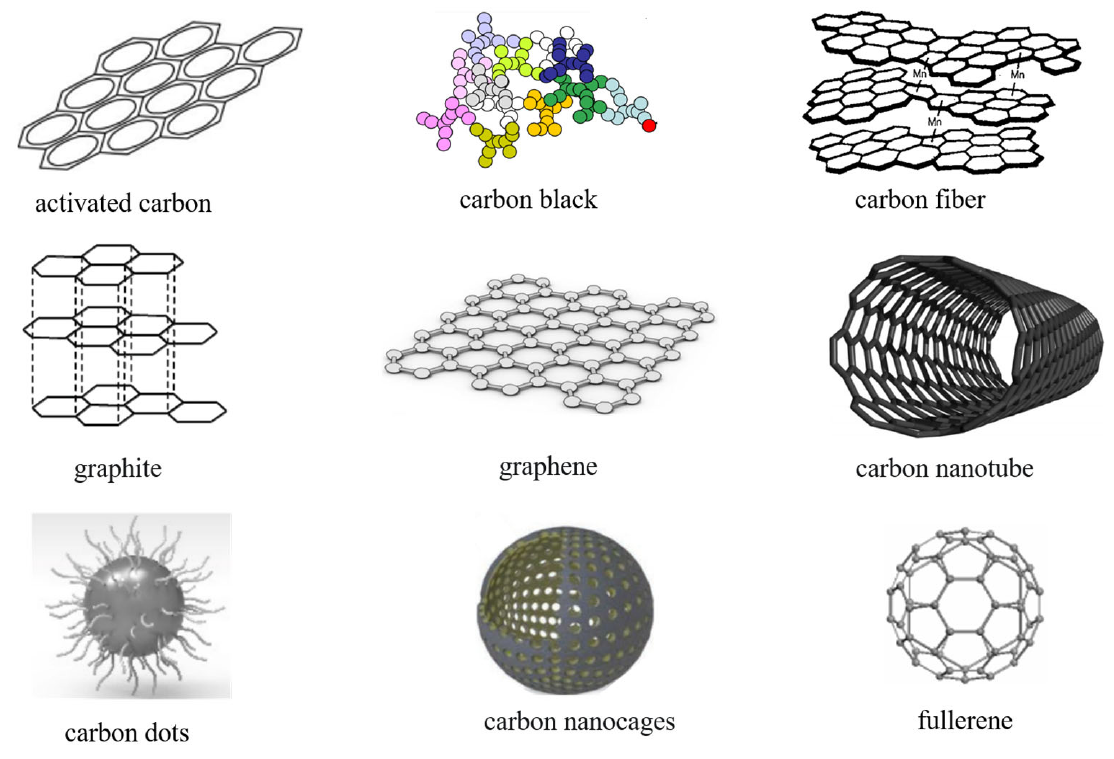
Figure 3. Structures of various carbon ‐ based materials. Reproduced with permission from [61–69].